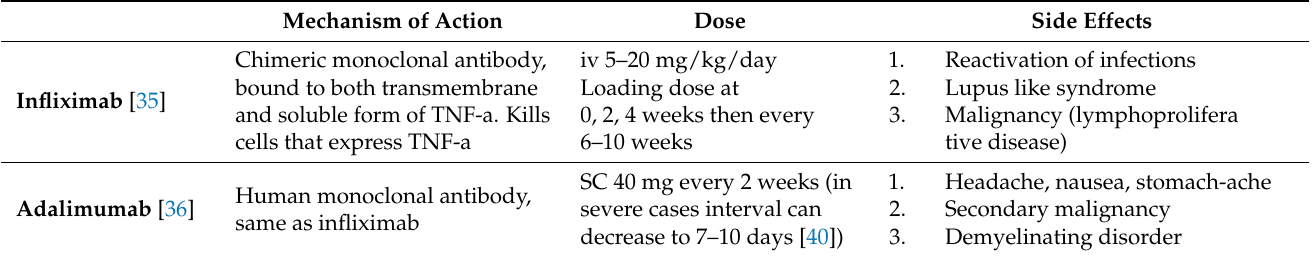
Table 3. Anti-TNF- α agents’ main